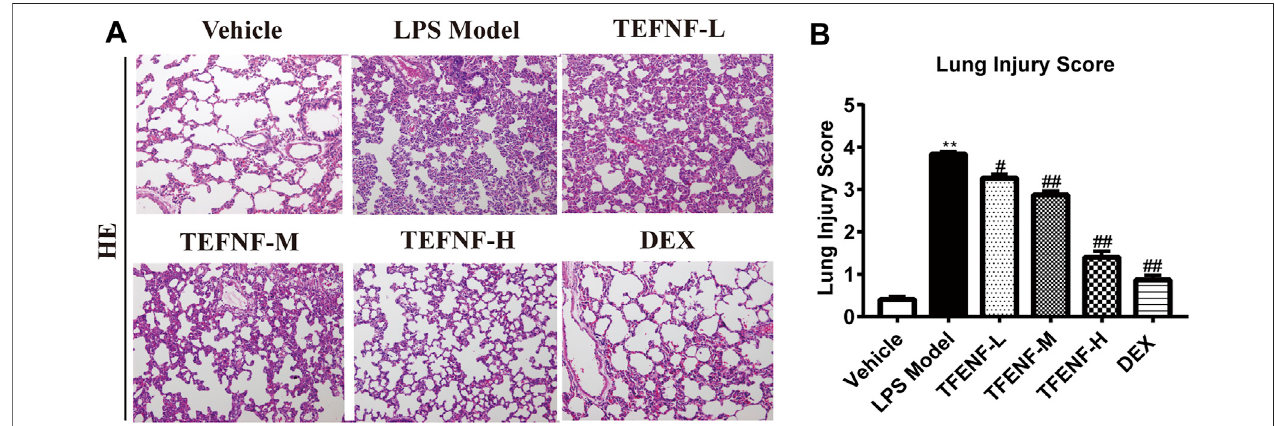
FIGURE 2 | TFENF protected against pulmonary pathological damage and in fl ammatory cell in fi ltration in LPS-induced ALI. Effect of TFENF on LPS-induced changes in lung histology (A) and lung injury score (B) 6 h after LPS challenge or saline treatment ( n (cid:2) 6 per group). Lung sections stained using H&E ( × 200). Lung injury scoresarepresented asmean ± S.E.M. ** p < 0.01 compared withthevehicle group; # p < 0.05 compared withtheLPSmodel group; ## p < 0.01comparedwiththeLPS model